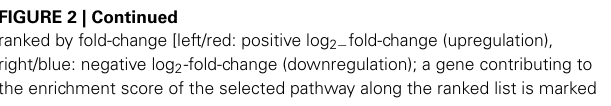
by a vertical black line and increases the cumulative enrichment score (green line)]. (G) qPCR analysis of the C4b gene ( ∗∗∗ p < 0 . 001 vs. 3M group, two-sided t -tests; # p < 0 . 05 vs. 24M group, two-sided t -test; n = 5[3M]/4[24M]/8[29M]). Error bars indicate